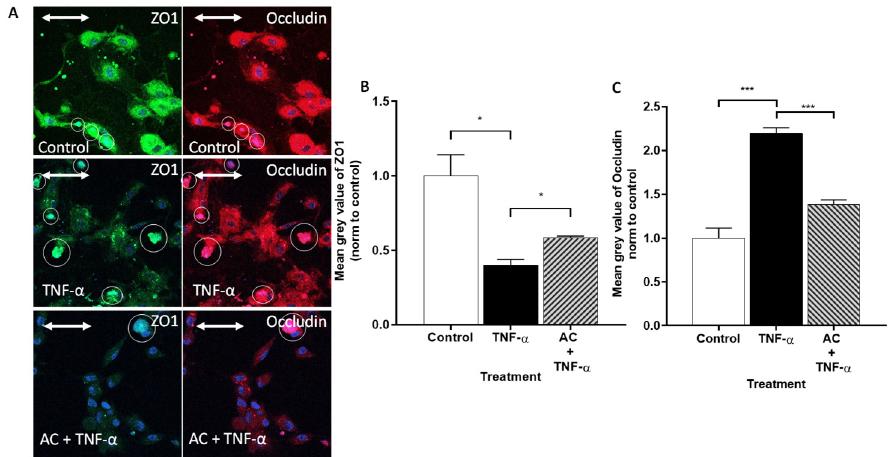
Figure 4. The effects of anthocyanin sour cherry extract on TNF- α induced ZO-1 and Occludin protein level. Human umbilical vein endothelial cells (HUVECs) were treated with TNF- α (10 ng/mL) and 85 µM AC + TNF- α (10 ng/mL) for 24 h. The protein level of ZO-1 and Occludin ( A ) were determined by immunostaining for Occludin and zonula occludens-1 (ZO-1) junctional proteins. Green color: immunostaining for ZO-1. Red color: immunostaining for Occludin. Blue color: staining of cell nucleus. Bar = 20 µm. The relative protein level of ZO-1 ( B ) and Occludin ( C ) were determined by mean gray value from immunostaining pictures. The means were normalized to untreated control. Data are presented as mean ± SEMs. n = 3. The significance of differences between sets of data was calculated by ANOVA. * p < 0.05, *** p < 0.001. The white circles indicate the regions that were not taken into account due to dye aggregation.